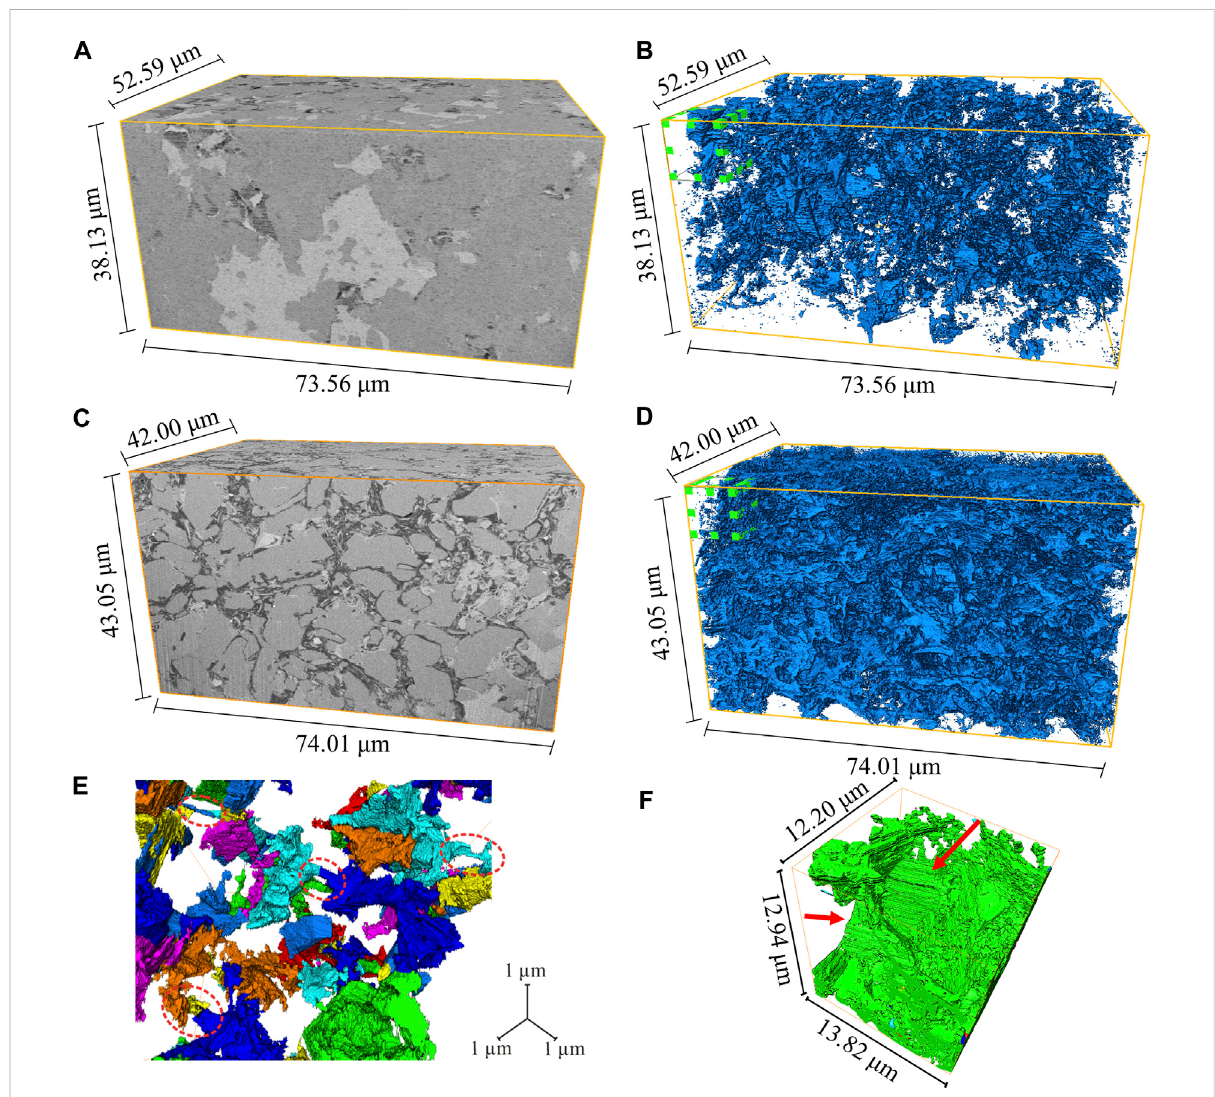
FIGURE 2 Digital rock models of samples G1and G2 derived from LV-FIB-SEM 3Dreconstruction. (A – D) Digital rock modelsand porenetwork models of samples G1 and G2, respectively; (E,F) close-up view of the structure of granular pores and slit-like pores in samples G1 and G2,